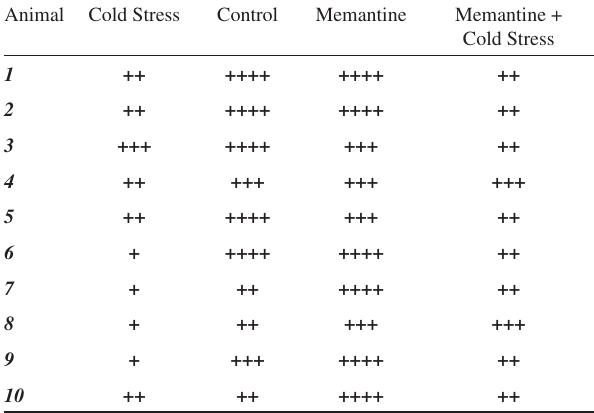
Table 2 - Glycogen depletion intensity in hepatocytes blushed with PAS method* (+=small intensity; ++++=high intensity) Animal Cold